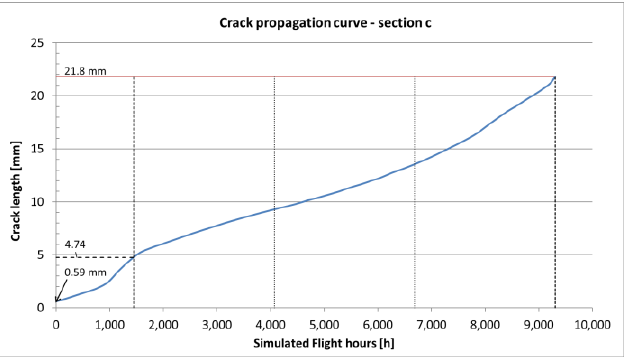
Figure 12. Crack propagation curve and inspection intervals definition for section c of CP2.